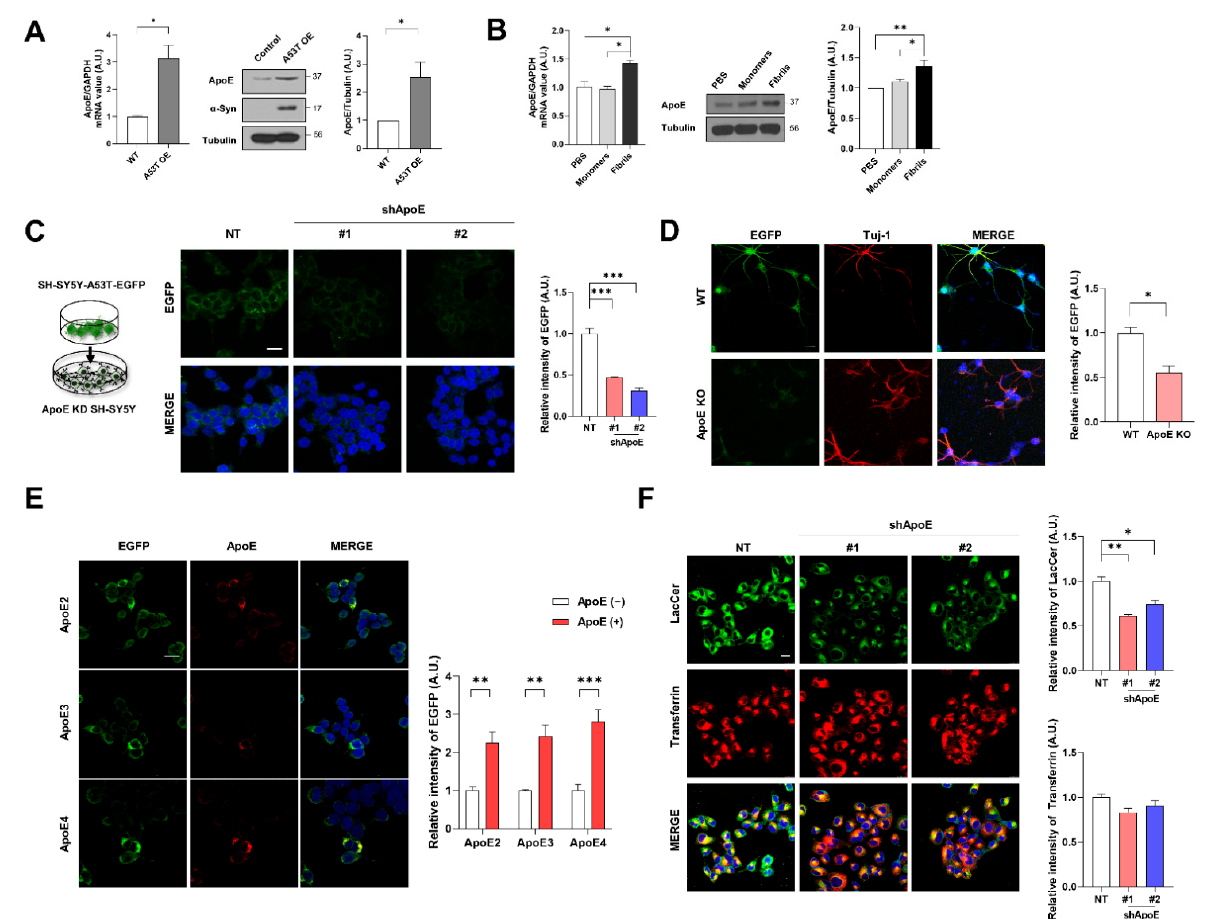
Figure 1. ApoE deficiency inhibits α -syn uptake into neurons. ( A ) ApoE expression in SH-SY5Y and A53T- α -syn OE SH-SY5Y cells was analyzed by RT-PCR and Western blot. Values were derived from three independent experiments ( n = 3). ( B ) After treatment with 1 μ M α -syn monomers and fibrils for 24 h, the cells were analyzed by RT-PCR and Western blot. Values were derived from three independent experiments ( n = 3). (C, D) NT, ApoE KD #1 and #2 SH-SY5Y cells ( C ) and primary neurons ( D ) were co-cultured with differentiated A53T α -syn-EGFP OE SH-SY5Y cells for 24 h using a dual chamber. The cells were then fixed and immunostained with anti-EGFP or anti-Tuj-1 antibodies. Values were derived from three independent experiments ( n = 3). ( E ) SH-SY5Y cells were transiently transfected with plasmids of ApoE isoforms (ApoE2, ApoE3, or ApoE4). The cells were co-cultured with differentiated A53T- α -syn-EGFP OE SH-SY5Y cells using a dual chamber. The cells were then fixed and immunostained with anti-EGFP and anti-ApoE antibodies. Values were derived from three independent experiments ( n = 3). ( F ) NT, ApoE KD #1, and #2 SH-SY5Y cells were incubated with 50 nM BOIPY ® FL C5-Lactosylceramide and 2.5 μ g/mL rhodamine-conjugated transferrin for 60 min. The intensity was analyzed with ImageJ and the LASX program. Values were derived from three independent experiments. * p < 0.05, ** p < 0.01, *** p < 0.001 against control; one-way ANOVA or unpaired t-tests. Blue indicates DAPI staining. Scale bars indicate 20 μ m.